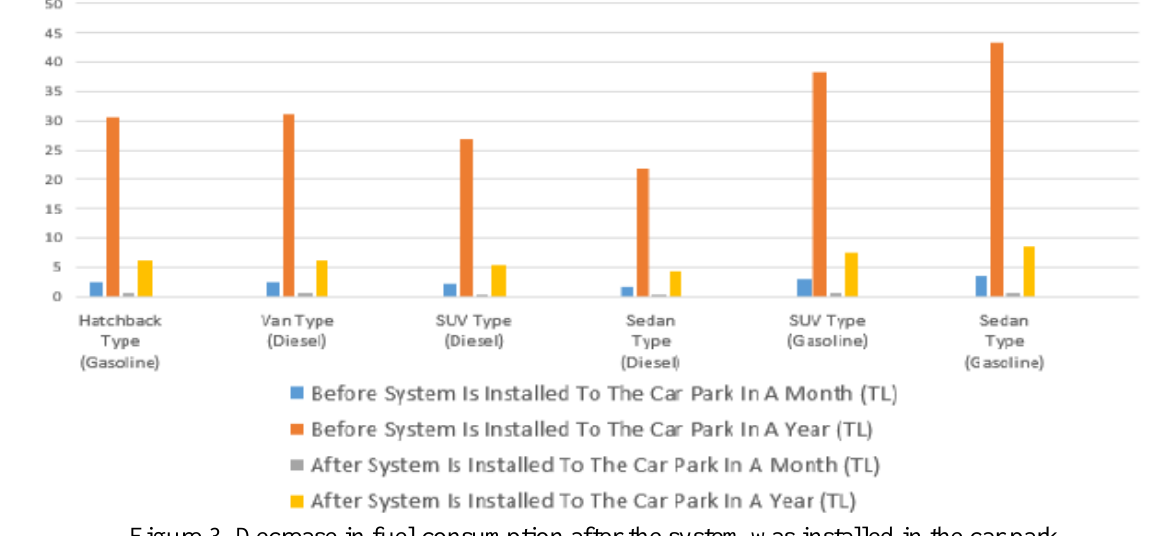
Figure 3. Decrease in fuel consumption after the system was installed in the car